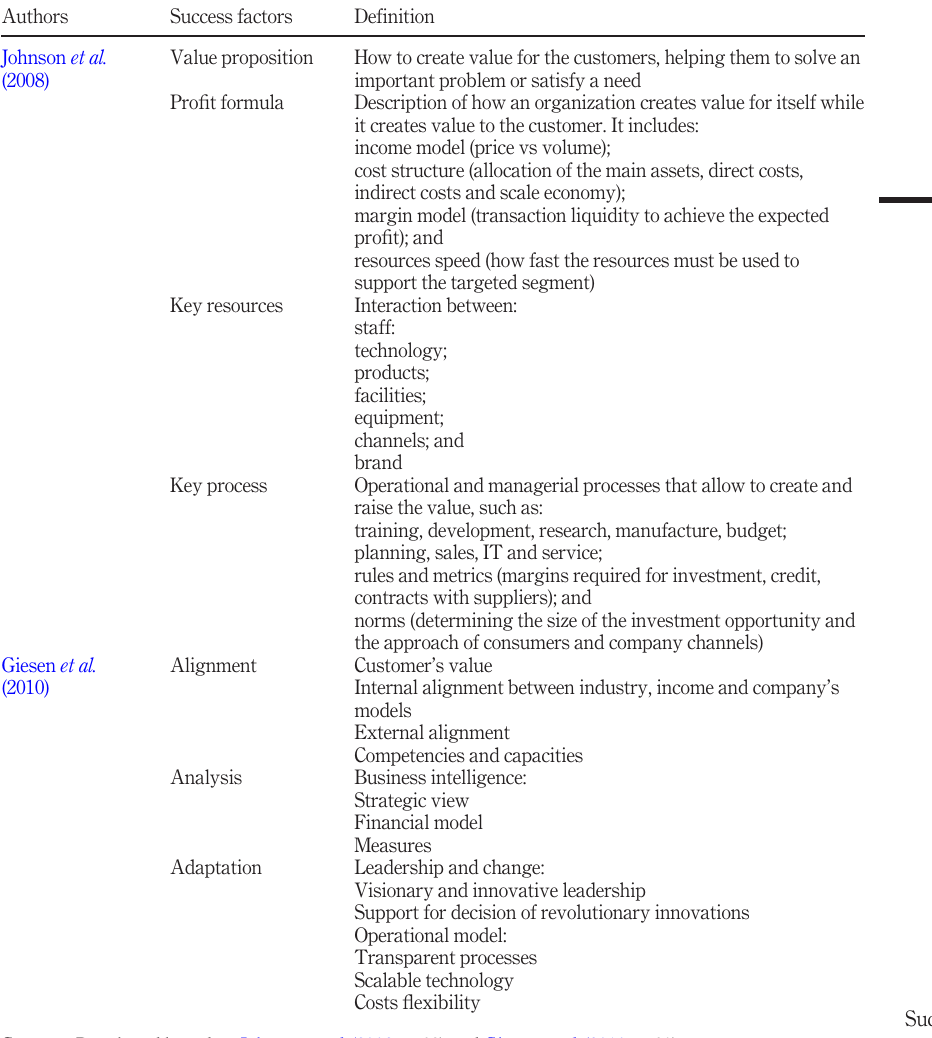
Table III. Success factors